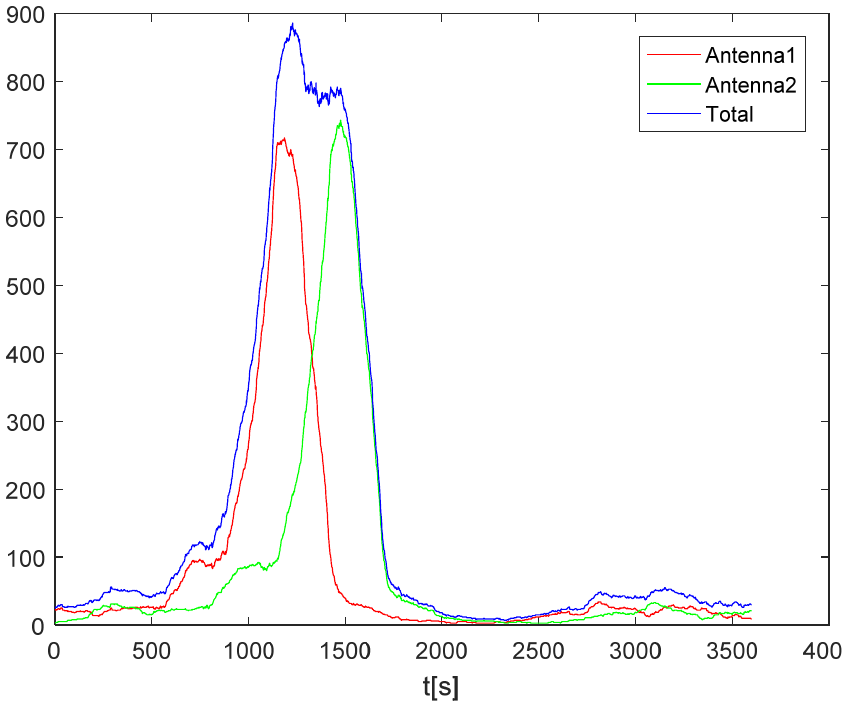
Figure 8. The number of available observations.